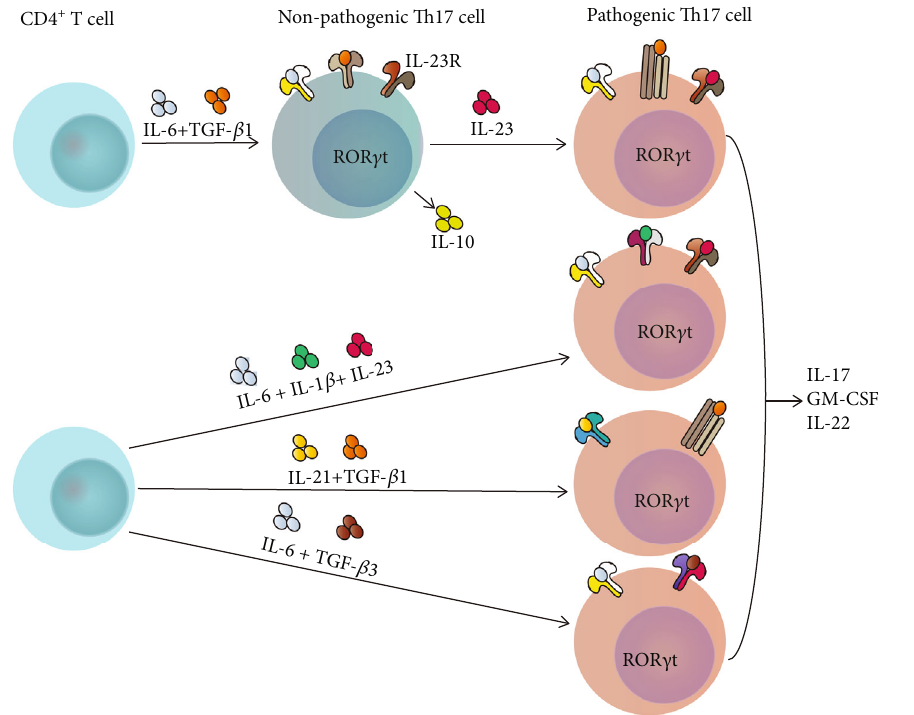
Figure 1: Di ff erentiation of two subsets of Th17 cells in